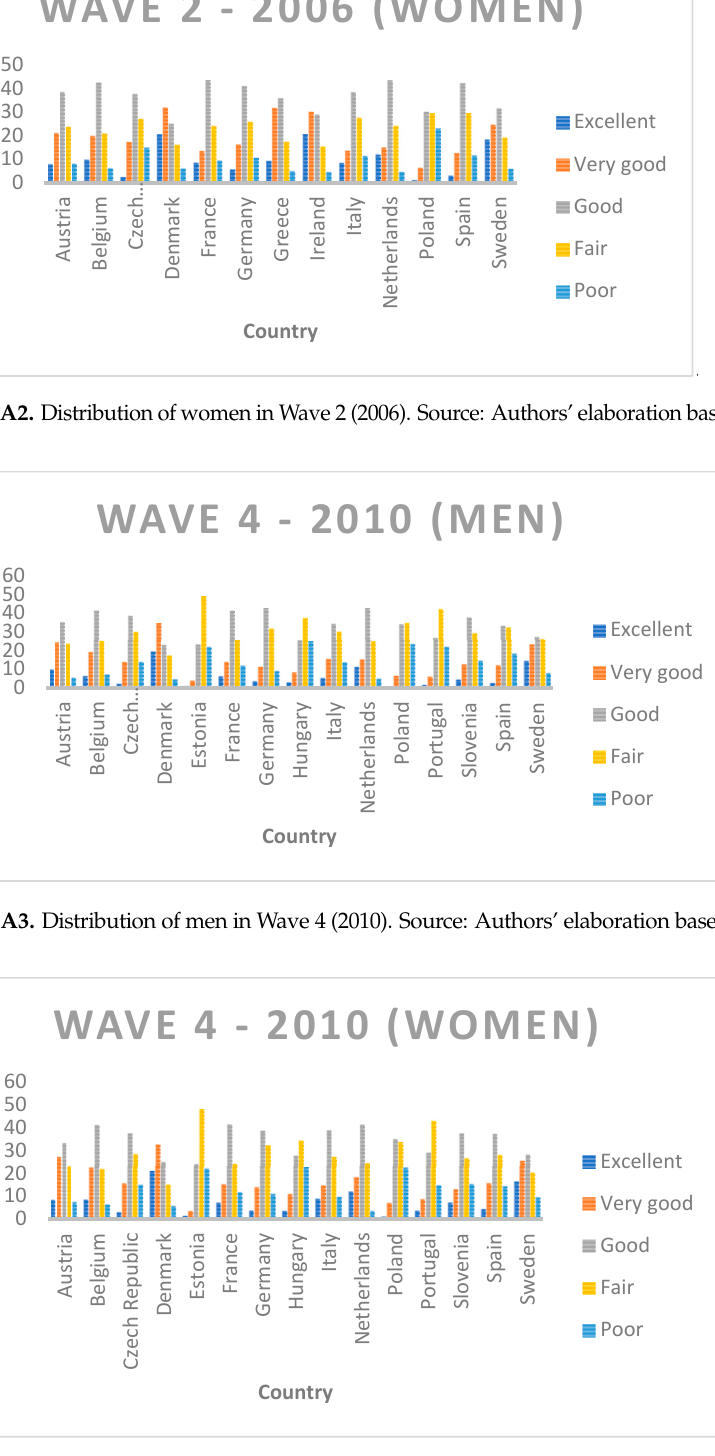
Figure A4. Distribution of women in Wave 4 (2010). Source: Authors’ elaboration based on SHARE (2021).